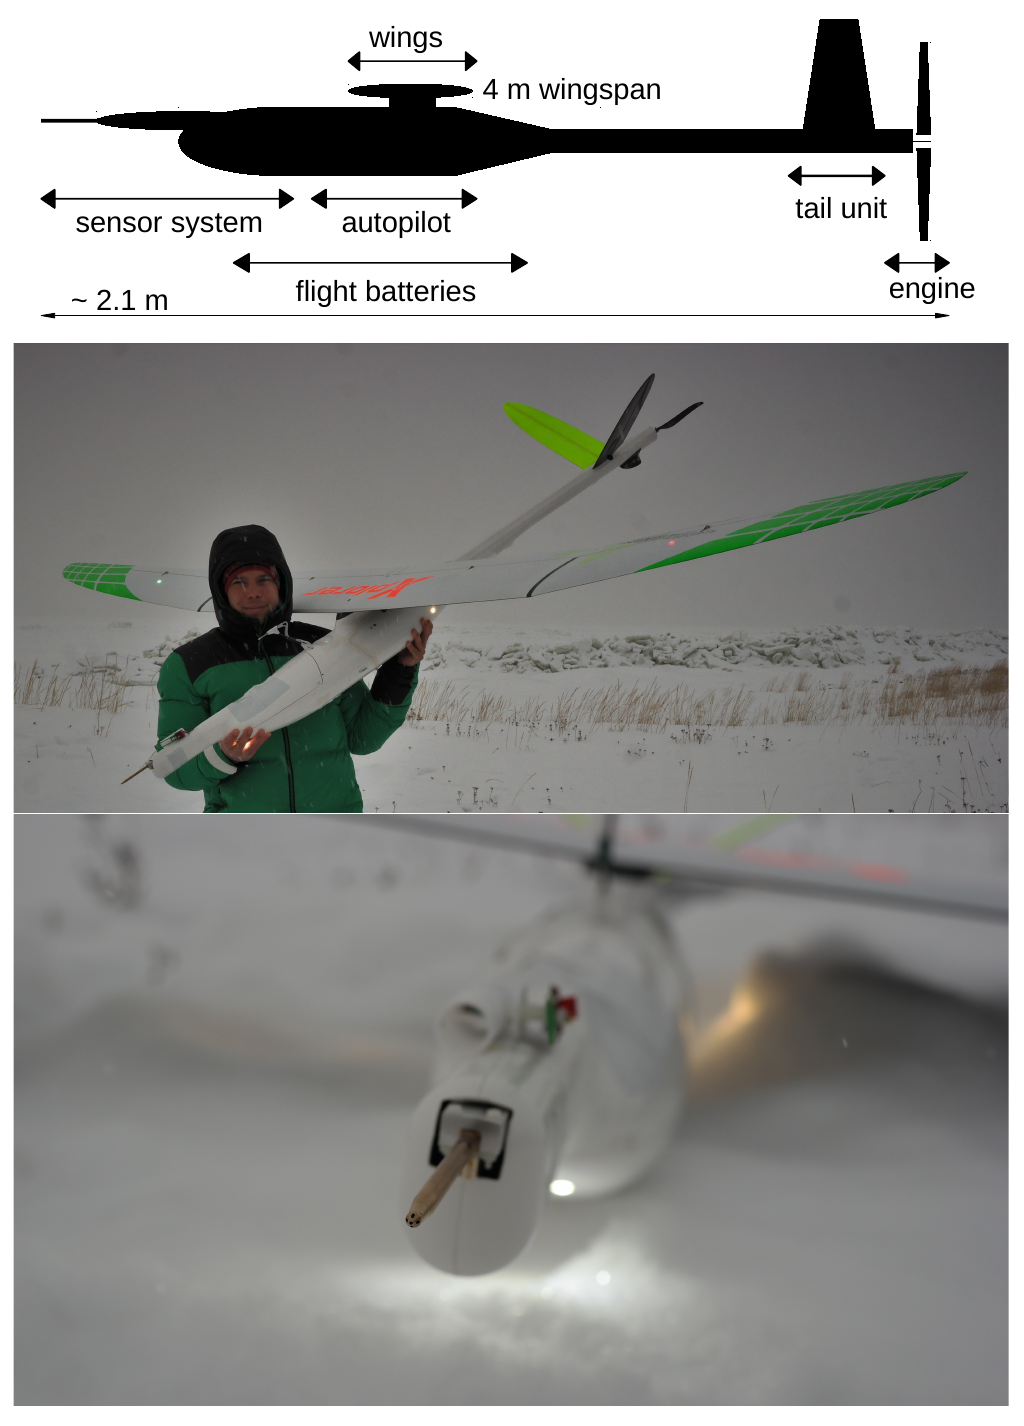
Figure 1. Multi-Purpose Airborne Sensor Carrier (MASC-3) sketch ( top ) and pictures of the airframe with the sensor system ( middle ) and five-hole probe ( bottom